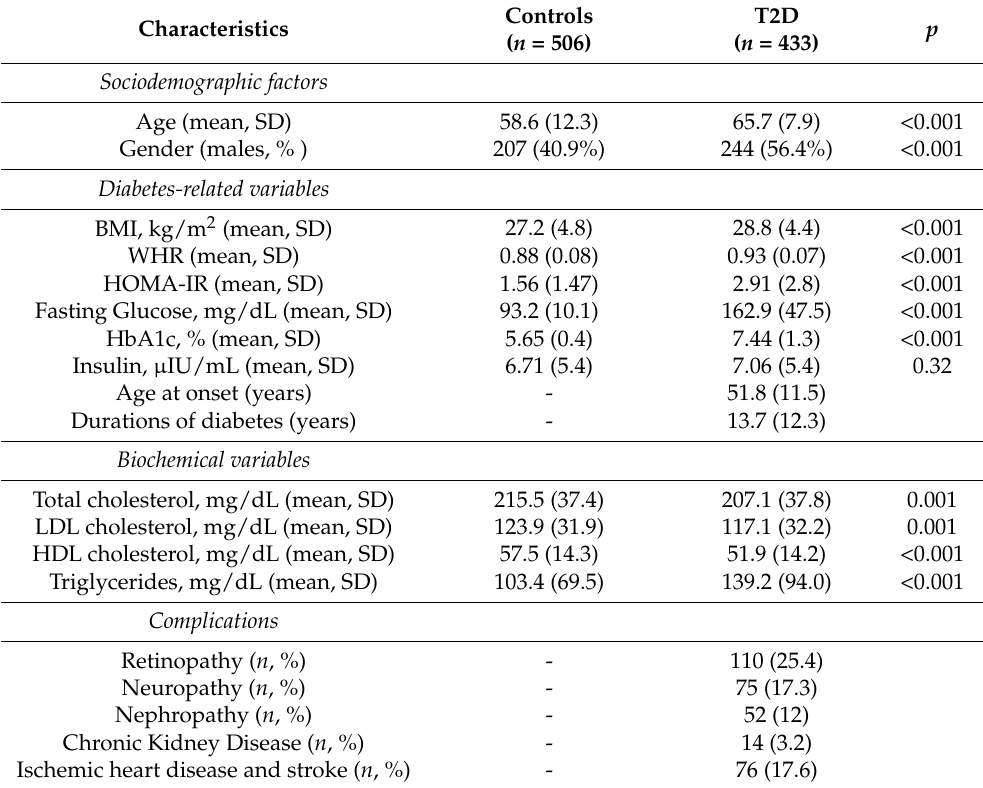
Table 1. Clinical and biochemical characteristics healthy control subjects and patients with Type 2 Diabetes (T2D).